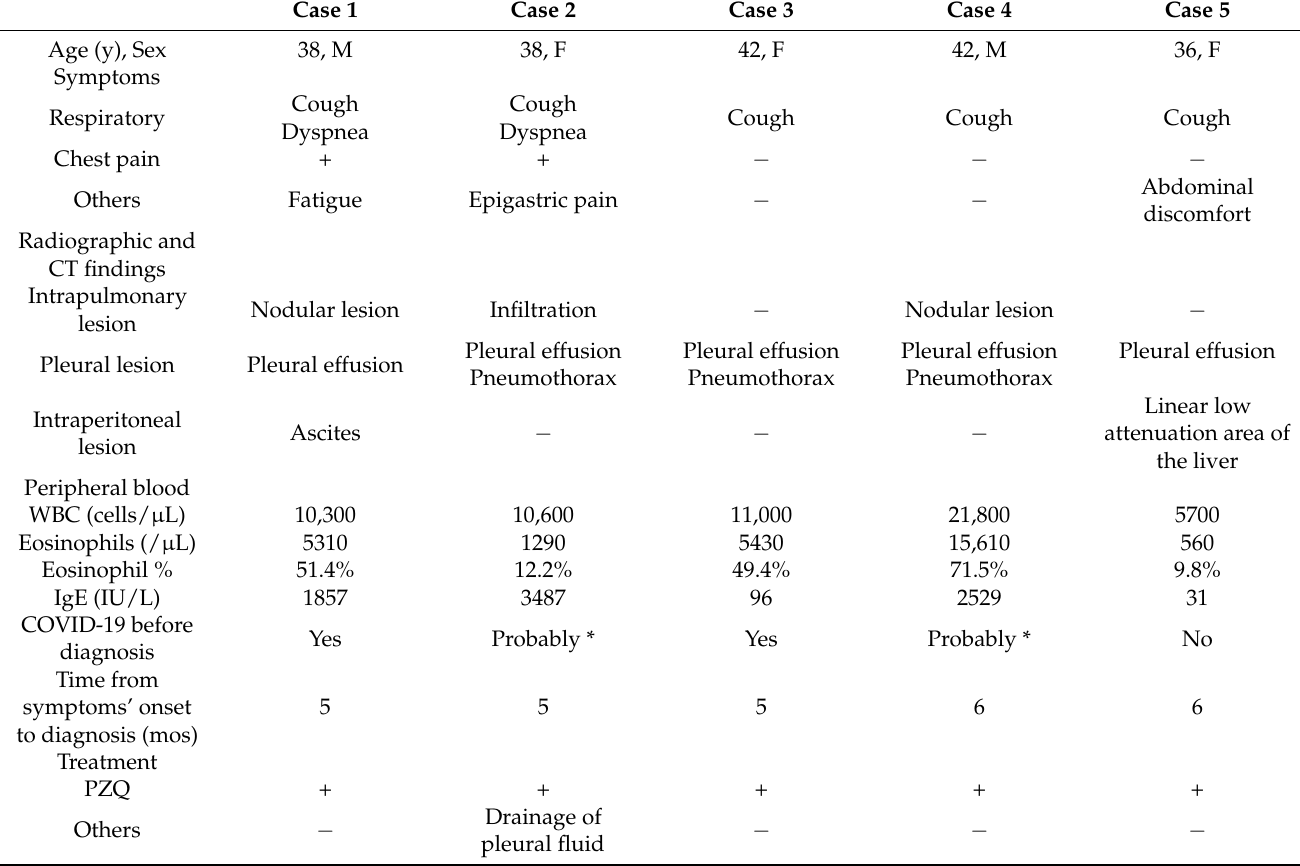
Table 1. Clinical findings of the five cases